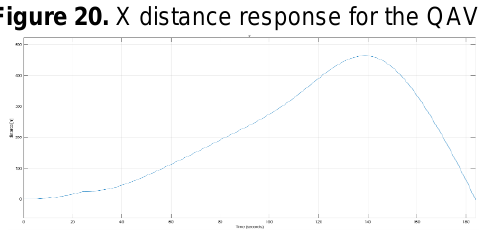
Figure 25. W linear velocity function with time for the QAV